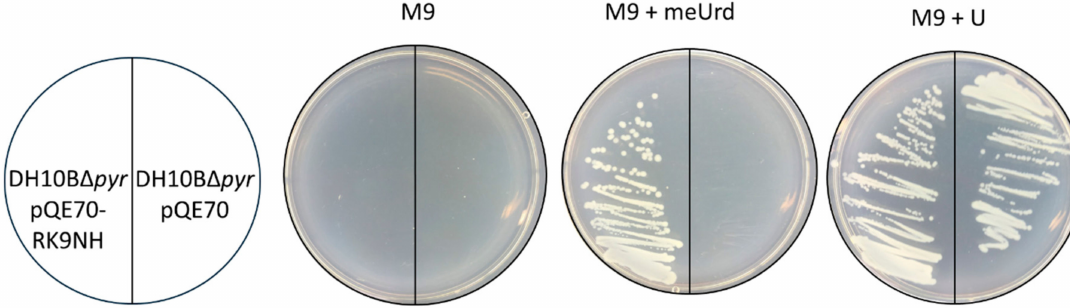
Figure 4. In vivo functionality of RK9NH coded in pQE70 vector. An empty vector was used as negative control. M9 was supplemented with 100 mg/L ampicillin, 15 mg/L kanamycin and either with 20 mg/L 2 (cid:48) - O -methyluridine (meUrd) or uracil (U, positive control).